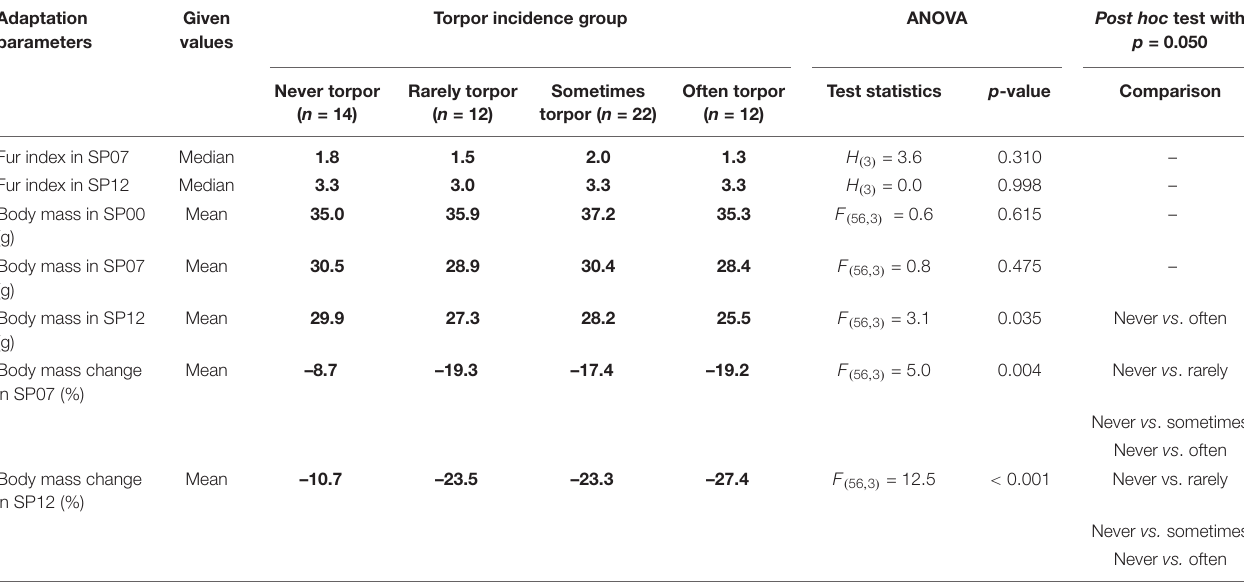
TABLE 2 | Phenotyping of the torpor incidence groups according to the adaptation parameters of approach